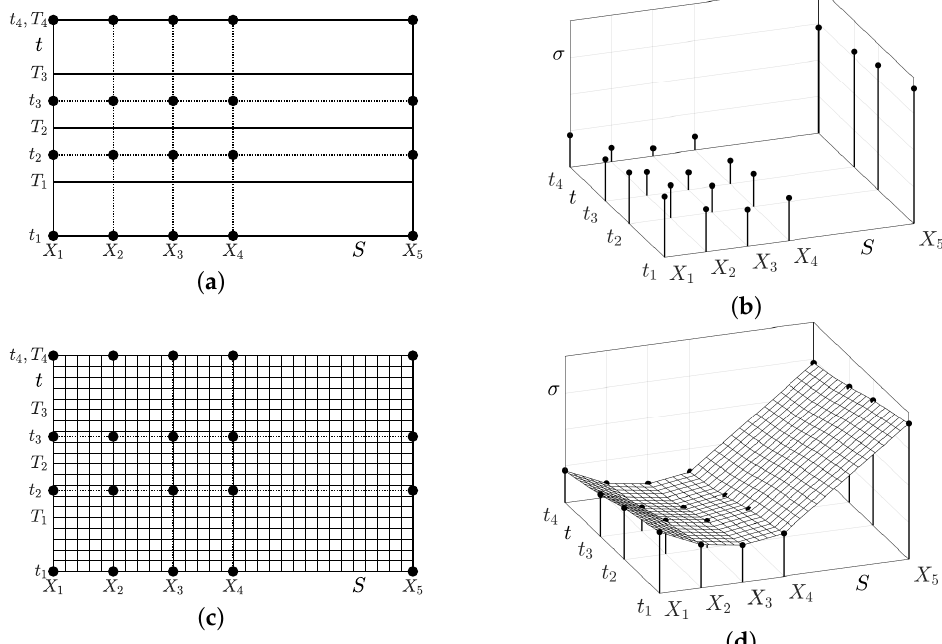
Figure 2. Schematics of the local volatility function in the proposed scheme: ( a ) sample point coordinates, ( b ) sample volatility values at the sample points, ( c ) grid used in the finite difference method, and ( d ) interpolated volatility values at the grid of query